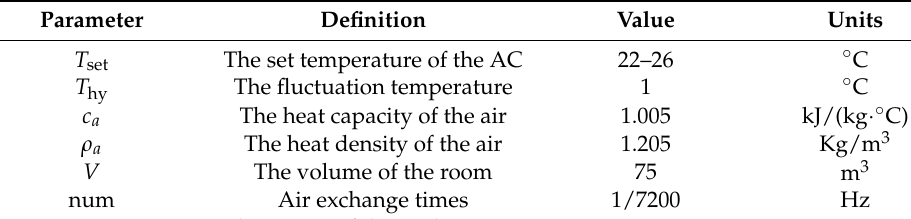
Table 1. The parameters of the AC model and the thermal model.